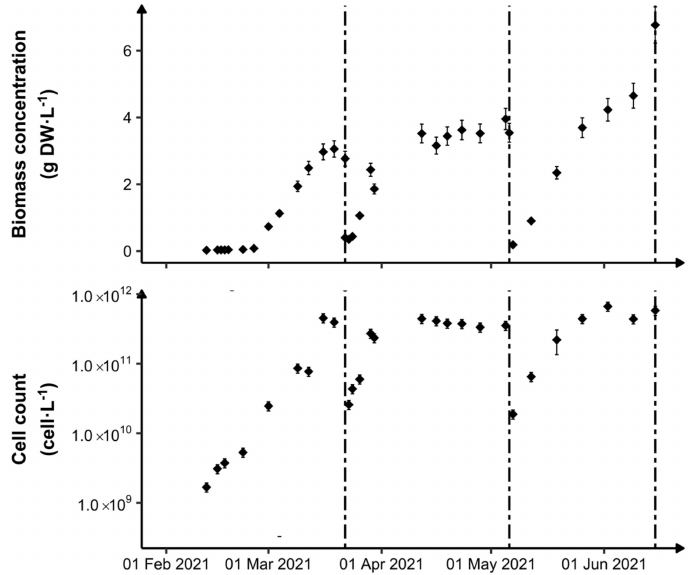
Figure 1. Evolution of biomass growth throughout the study. The dotted vertical line indicates the days the reactor was partially